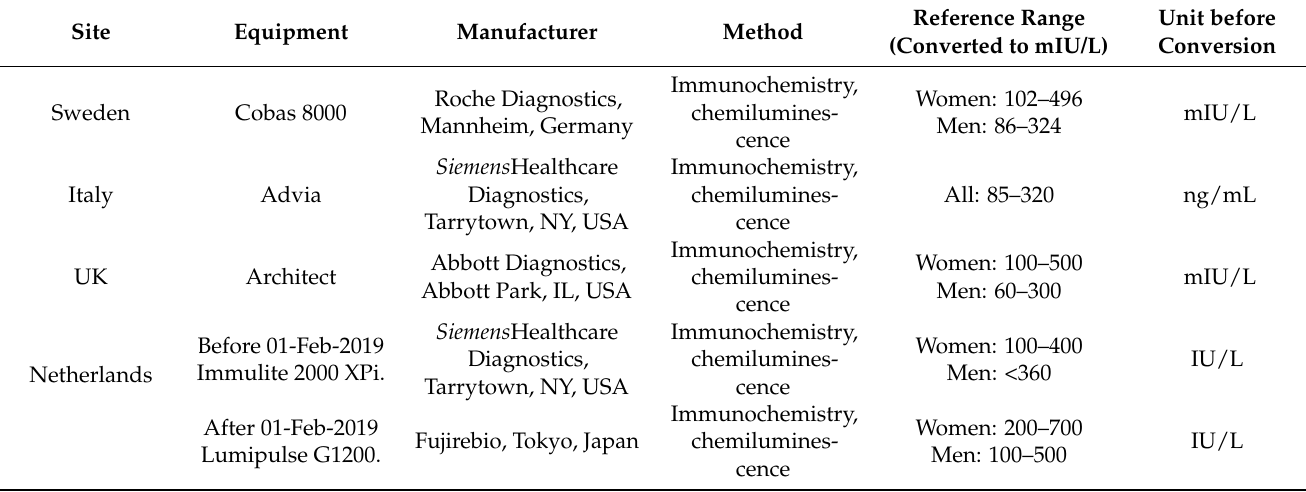
Table A1. List of prolactin assay